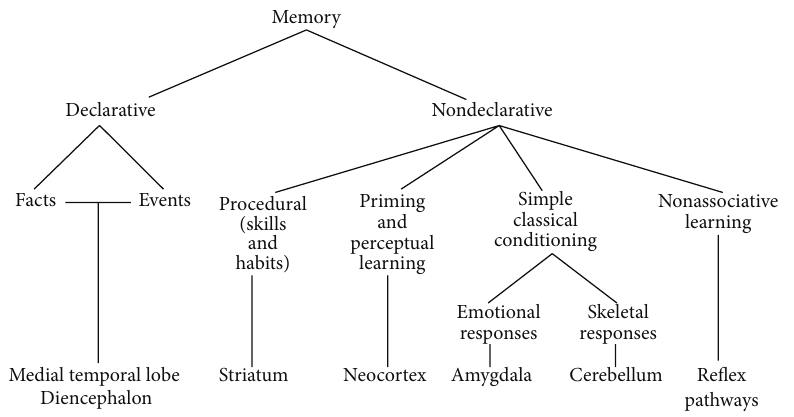
Figure 3: Taxonomy of multiple memory systems [37].